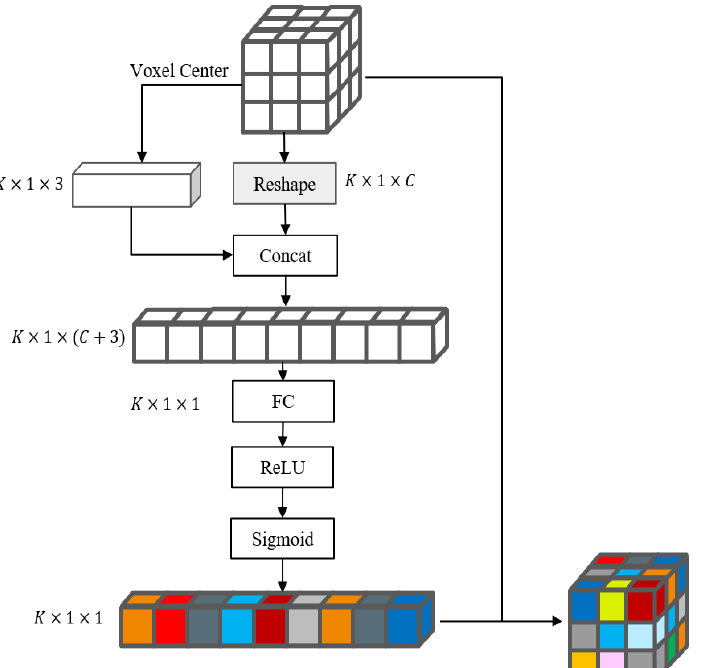
Figure 3. The structure of voxel attention module. The reshape operation permutes the dimension of the tensor from W × H × D × C to K × 1 × C